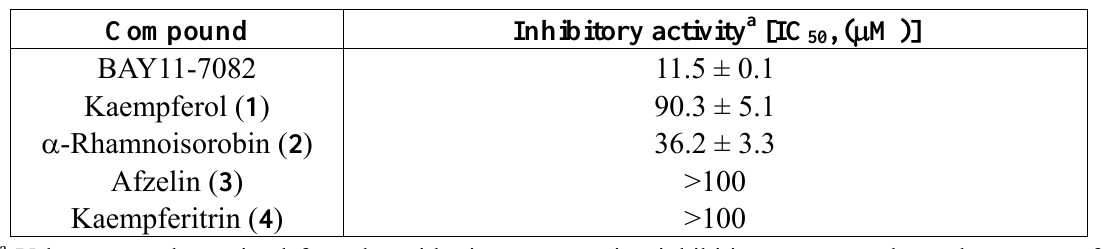
Table 3. Effects of kaempferol and its glycosides on the NF- κ B-mediated luciferase